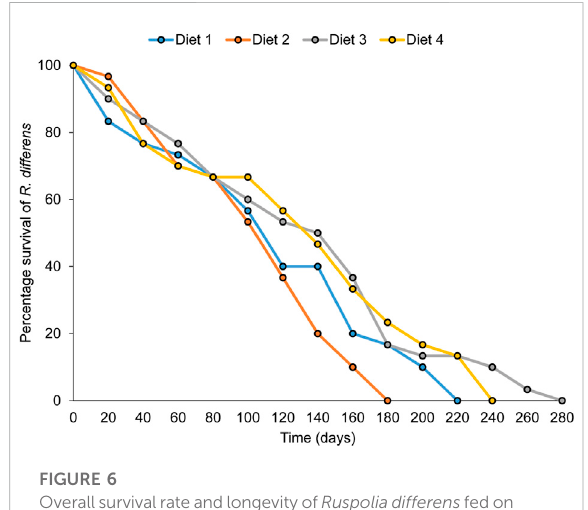
FIGURE 6 Overallsurvivalrateandlongevityof Ruspoliadifferens fedon the various